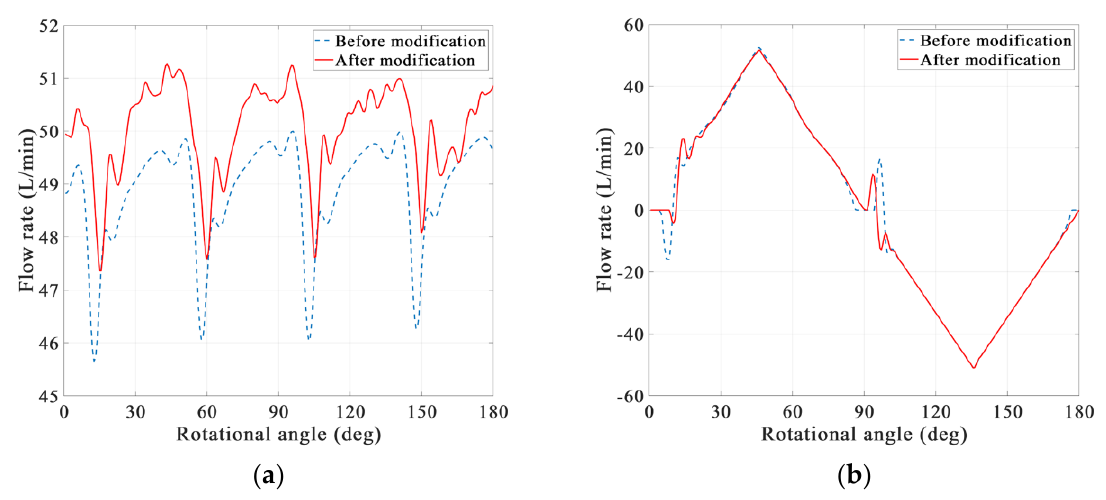
Figure 20. Comparisons of ( a ) the outlet flows and ( b ) the outlet pressures.